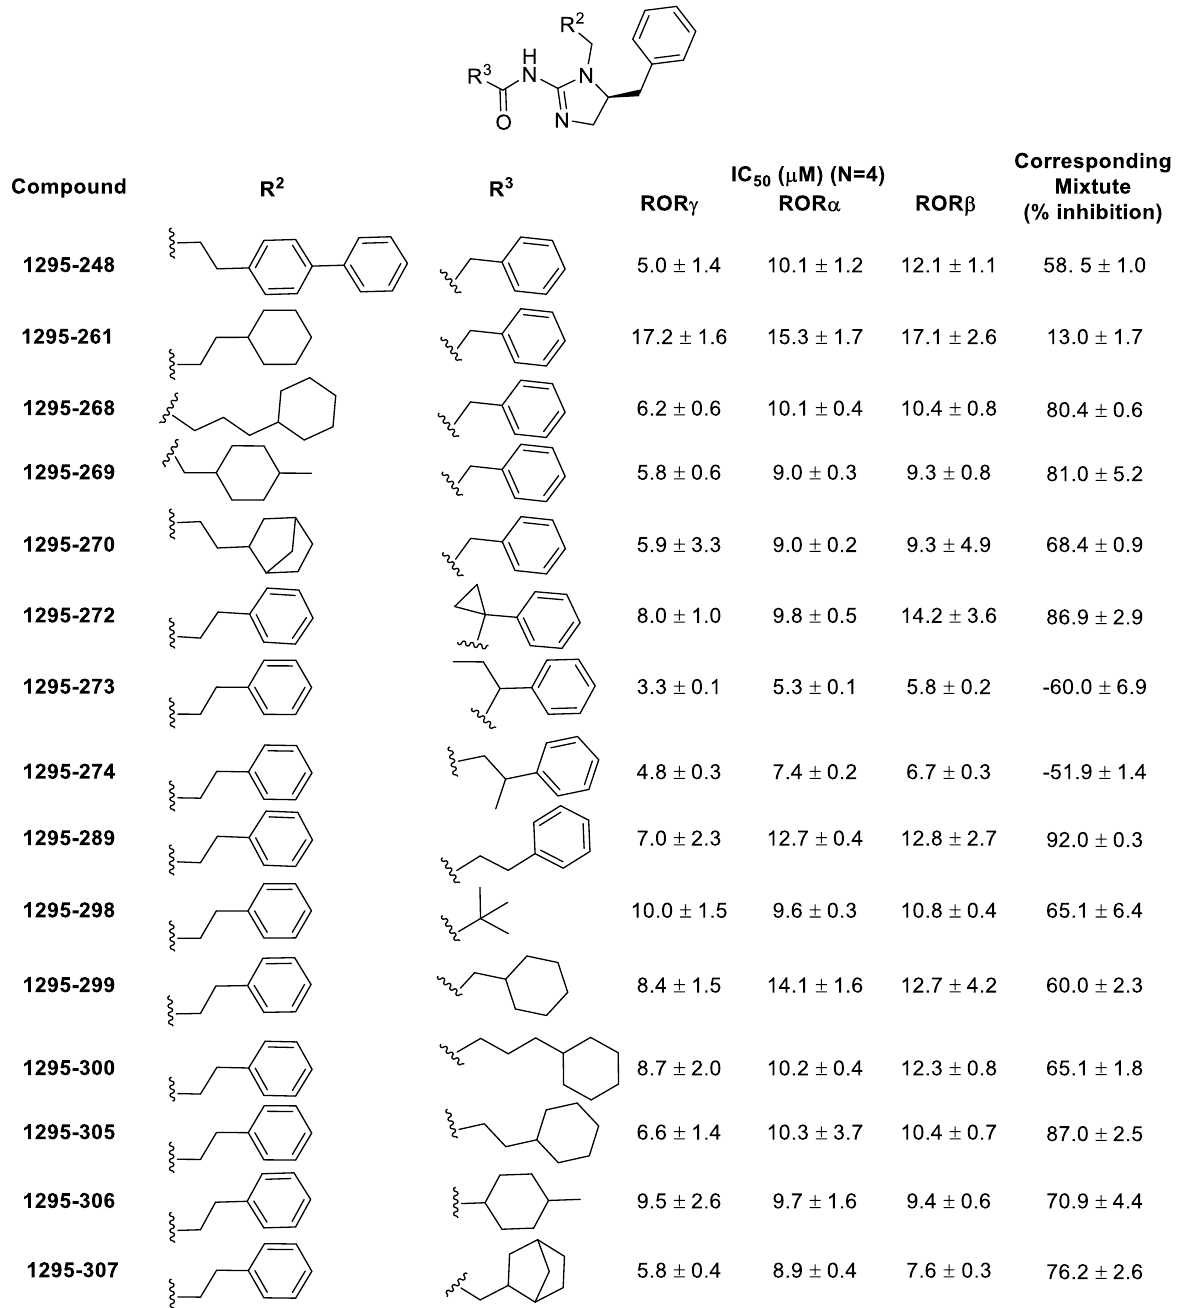
Figure 2. Effect of individual controls from library 1295 on ROR-dependent luciferase activity. The IC50 values (in µM) for each cell line and the chemical group at each position are shown. The right column shows the percentage of inhibition observed in RORγ cells incubated with 10 µg/mL of the corresponding mixture library containing the indicated fixed R2, or R3 functional groups.